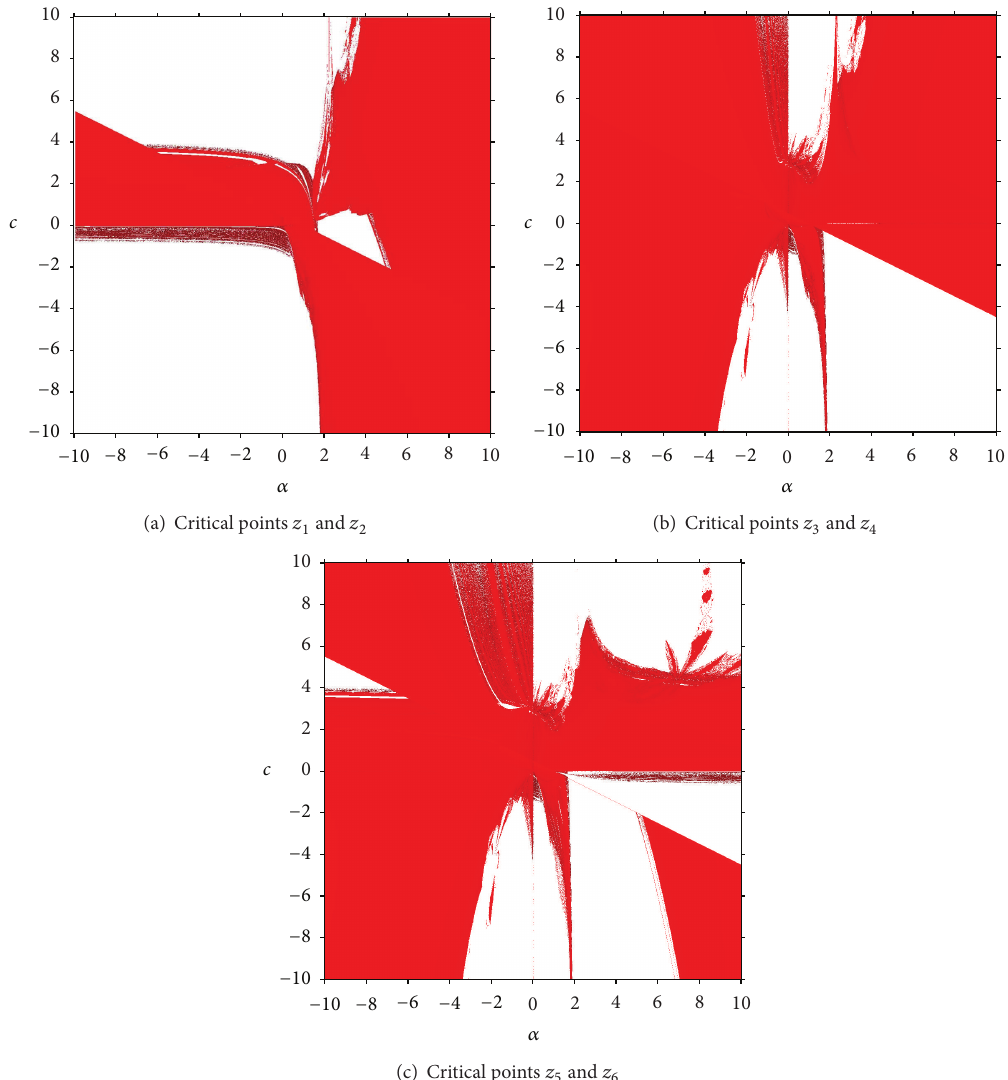
Figure 8: Parameter planes corresponding to different critical